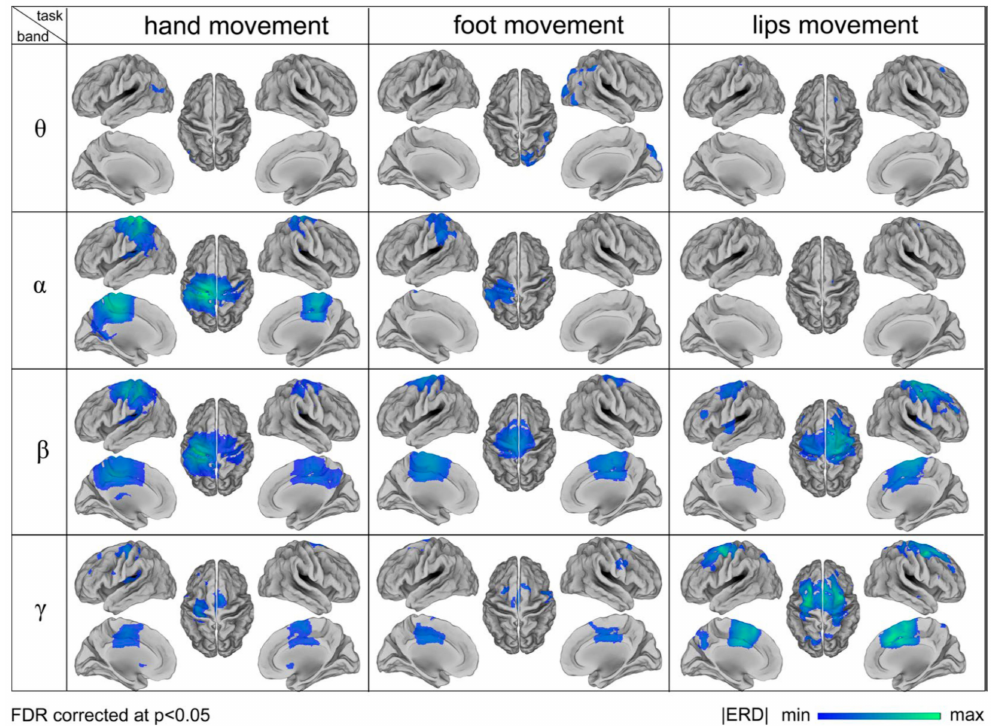
Figure 5. Comparison of brain activity monitored during hand, foot, and lip movement [35].